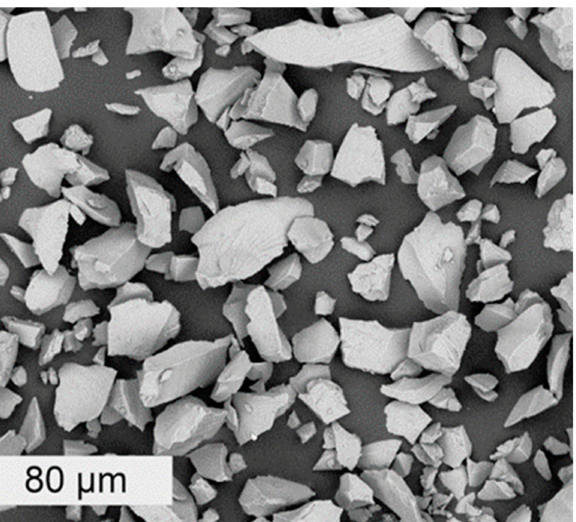
Figure 1. SEM micrograph of the pristine International Simple Glass (ISG) powder used in the dissolution experiments.